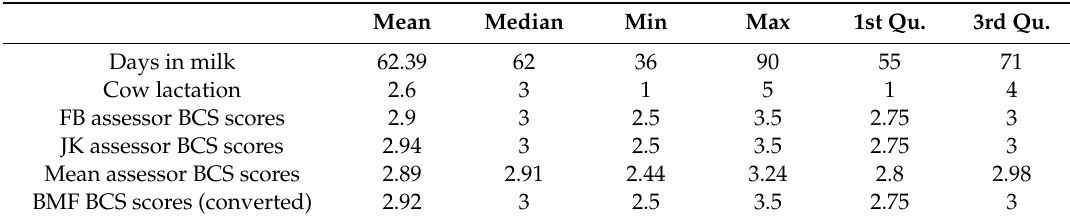
Table 2. Descriptive statistics as of 12 April